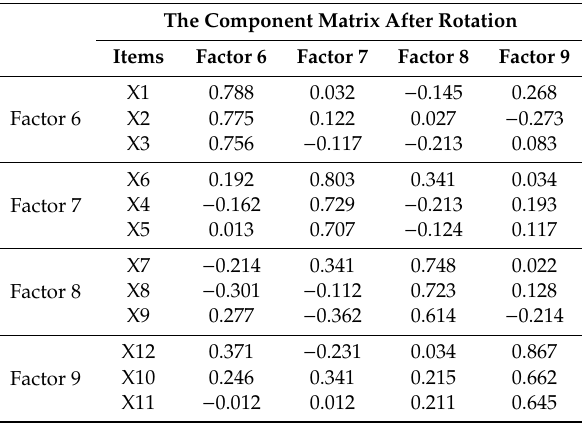
Table 6. Rotational matrix of safety citizenship